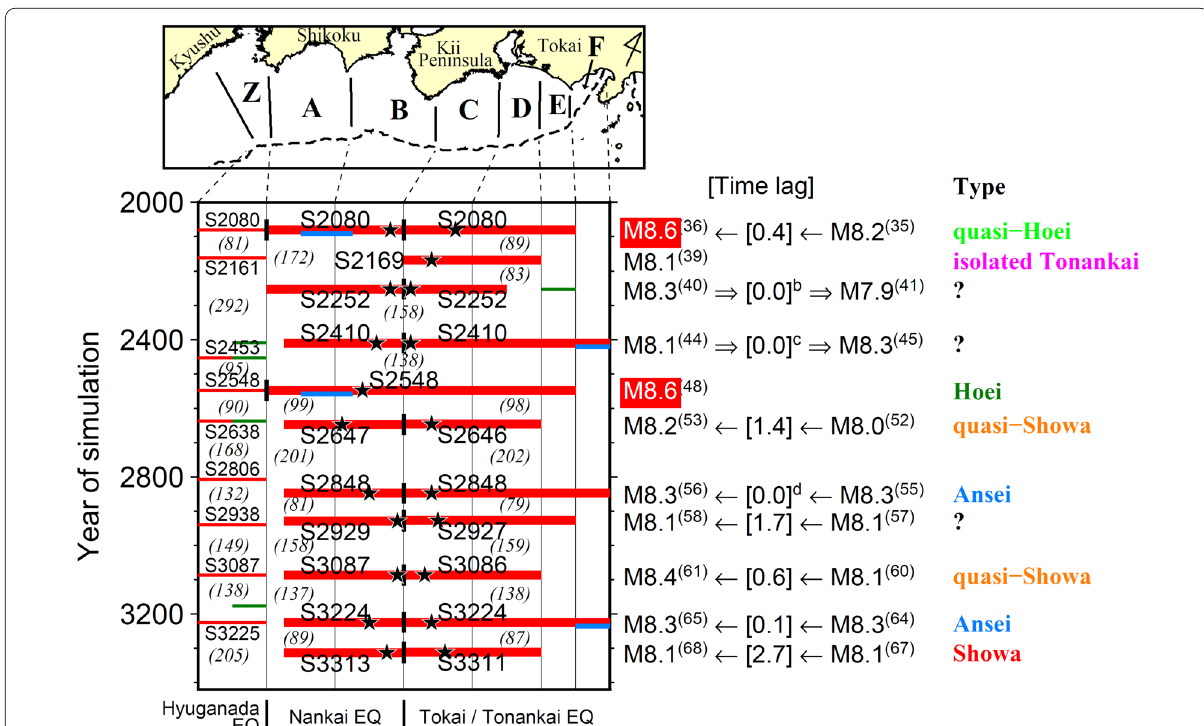
Fig. 6 Occurrence times and source regions of great Nankai Trough earthquakes during years S2000–S3400 of our simulation. Stars indicate rupture initiation points. Blue lines indicate rupture segments with large slips (> 5 m) near the trough axis. Red horizontal lines in area Z indicate Hyuganada earthquakes with M w ~ 7.5; green lines in areas E and Z indicate M w 6-class earthquakes. Numbers in parentheses indicate years between successive earthquakes. Annotation on the right side lists the magnitudes of Nankai and Tokai/Tonankai earthquakes; the superscripts indicate the event number, corresponding to the plots in Figs. 5 and Additional file 1: S2. Mega-earthquake magnitudes are shown in white on red background. The numbers in brackets indicate the time lag in years between the Tokai/Tonankai and Nankai earthquakes of event pairs; event pairs with superscripts b, c, and d mean time lags of 2 days, 1 day, and 2 weeks, respectively. The arrows indicate the occurrence order of great earthquakes, and the open arrows indicate the cases where the Nankai earthquake preceded. The earthquake types, shown on the right, are described in the text. Their colors correspond to Fig. 5. Question marks indicate rupture patterns that cannot be classified into any of six representative earthquake types shown in Fig.